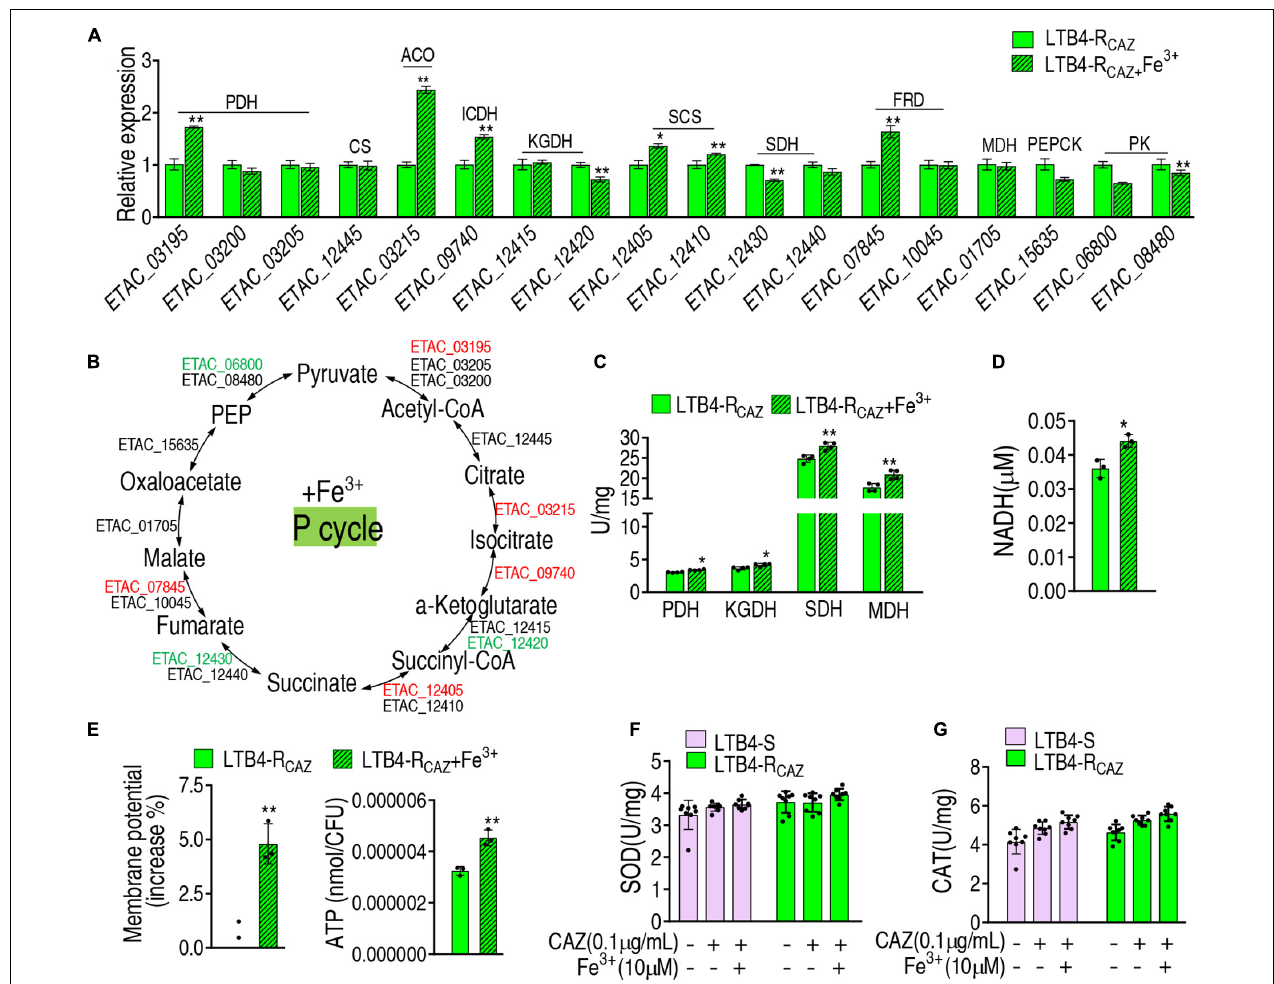
FIGURE 5 | The effect of Fe 3 + on the P cycle. (A) qRT-PCR for expression of the P cycle genes in the presence of Fe 3 + . (B) A global view for transcription level of the P cycle genes. Red and blue indicate upregulated and downregulated expression, respectively. The activity of enzymes of the P cycle (C) , NADH level (D) , membrane potential (E) , and ATP (F) of LTB4-R CAZ in the presence or absence of Fe 3 + . (G) The activity of SOD and CAT in the presence or absence of ceftazidime or/and Fe 3 + . Results (A,C–G) are displayed as mean ± SEM, as determined by two-tailed Student’s t -test. Four biological repeats are carried out. * p < 0.05 and ** p <